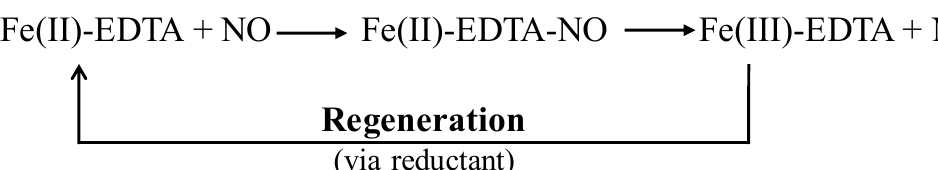
Figure 5. NO absorption, reduction and regeneration of Fe(II)-EDTA by external reductant. Table 3. The commonly used electron donor for regeneration of Fe-EDTA (ferric to ferrous) by different people during NO x reduction via wet scrubbing (chemical reduction and biological reduction).